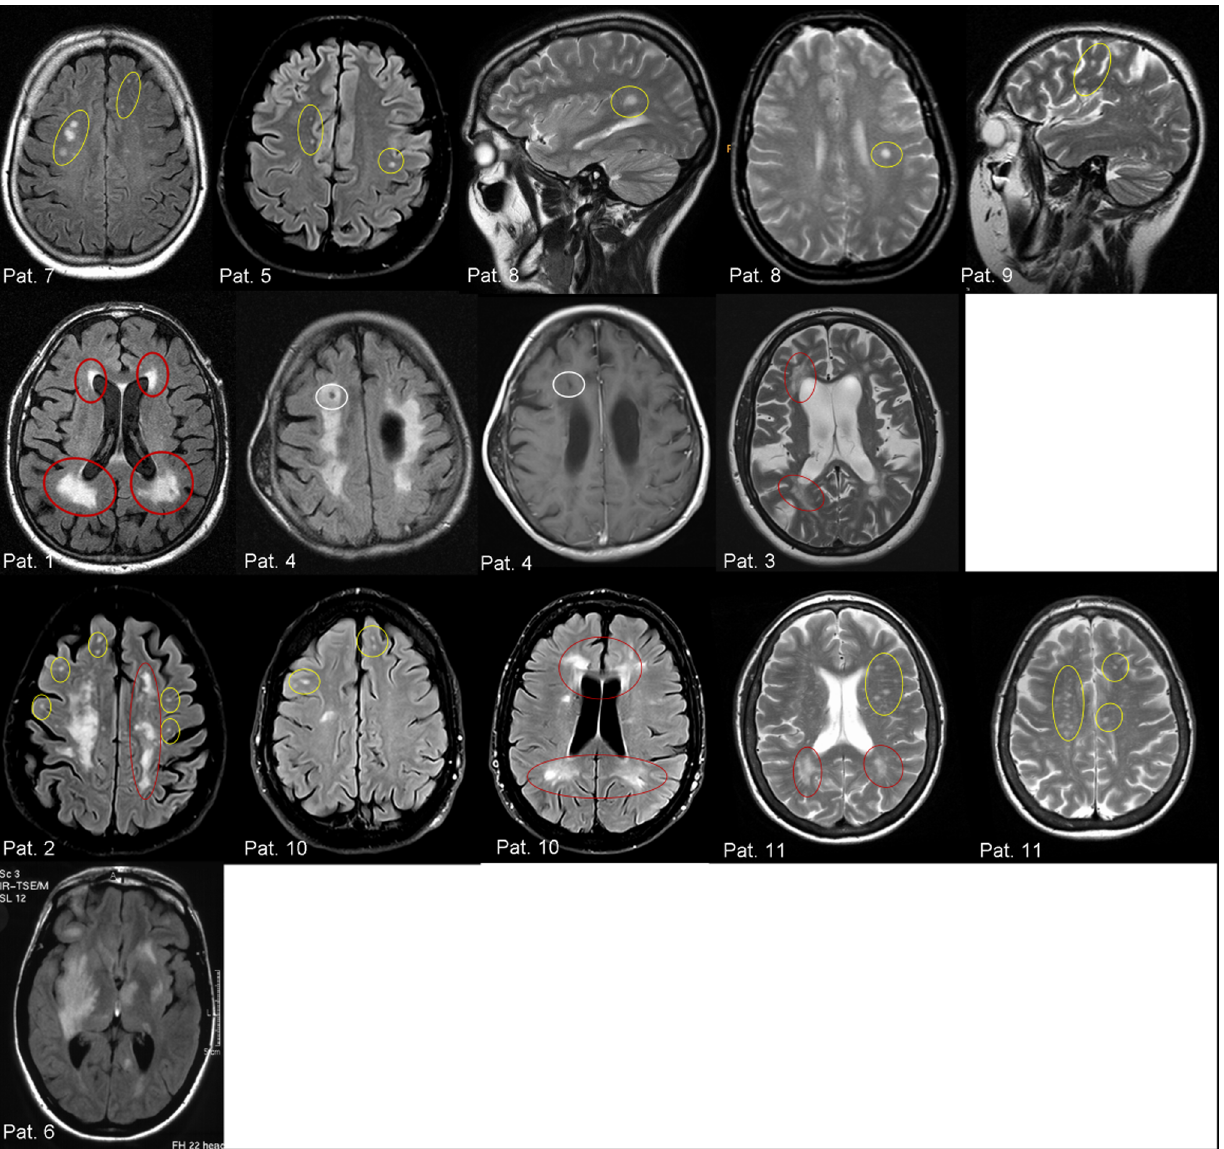
Figure 1. MR images (T2-weighted and FLAIR sequences) of 11 Fabry patients misdiagnosed with multiple sclerosis. Upper row: Patients 7, 5, 8 and 9 showed more punctuate and subcortical white matter lesions (yellow circles). Second row: White matter lesions in patients 1, 4, and 3 had a rather confluent, periventricular pattern (red circles). This pattern was associated with ‘‘black holes’’ (white circles) in T1-weighted images as a surrogate of severe demyelination and axonal injury. Third row: Patients 2, 10, and 11 revealed both disseminated and confluent, periventricular patterns. Fourth row: Only patient 6 showed an uncommon image with a severe, asymmetrical involvement of cortical, subcortical, and basal ganglia tissues.